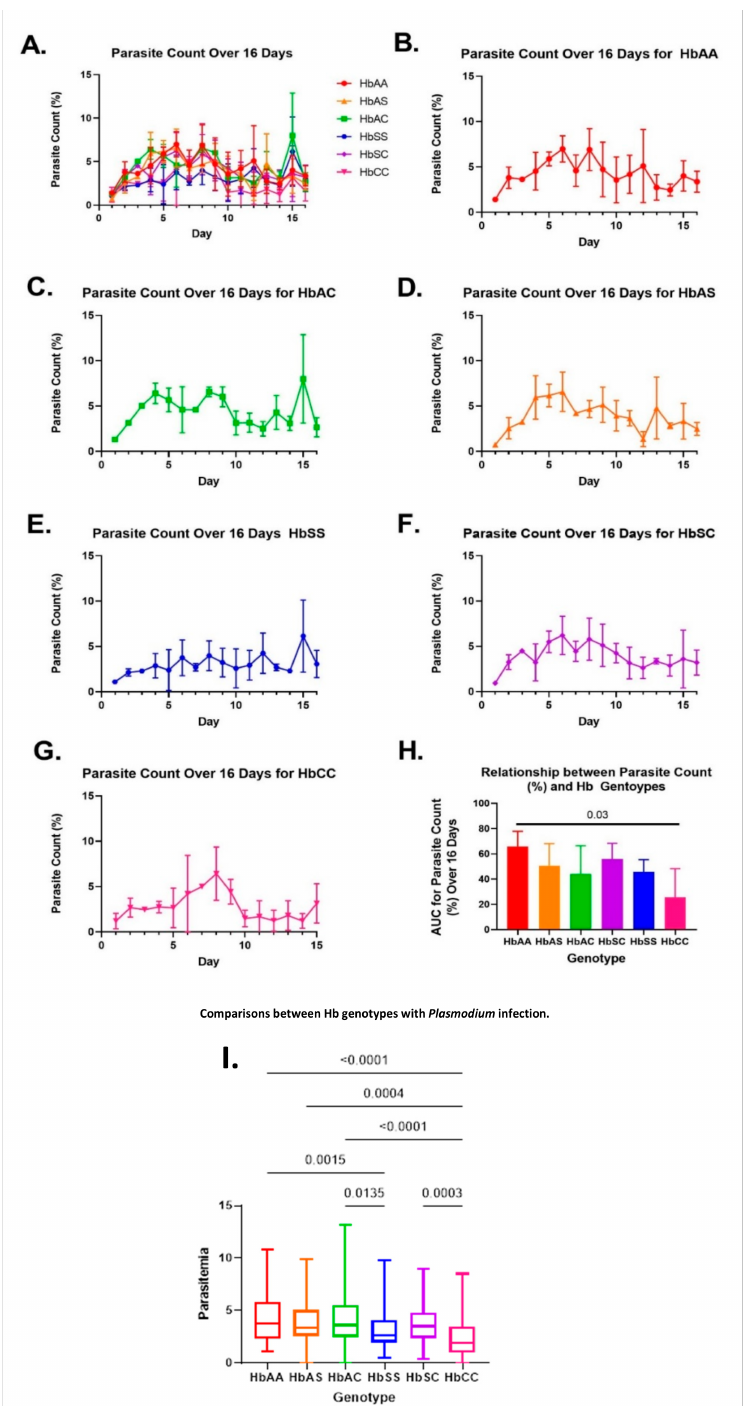
Figure 1. Parasite count percentage over 16 days culture of ( A ) all sickle Hb genotypes; ( B ) HbAA (red); ( C ) HbAC (green); ( D ) HbAS (orange); ( E ) HbSS (blue); ( F ) HbSC (purple); ( G ) HbCC (pink); and ( H ) area under the curve (AUC) for each genotype. AUC was used to estimate the overall parasite counts over 16 days. HbAA had significantly ( p = 0.03) more parasites compared to the HbCC group. ( I ) A one-way ANOVA and Tukey’s multiple comparison test on all the genotypes. The median parasitemia was significantly lower in HbSS ( p = 0.0015) and HbCC ( p < 0.0001) groups compared to HbAA and in both groups compared to HbAC ( p = 0.0135 and p < 0.0001, respectively). Additionally, the HbCC genotype had a significantly lower median parasitemia compared to HbAS and HbSC, with p = 0.0004 and p = 0.0003,